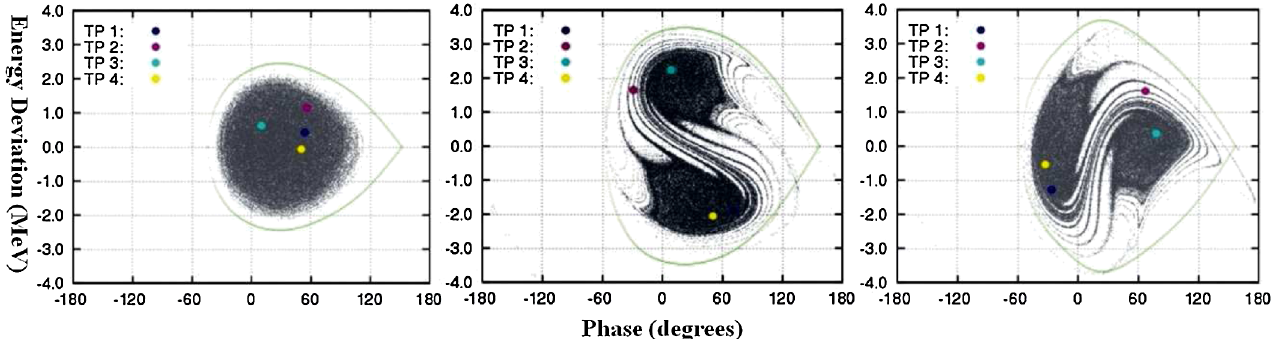
FIG. 4. (Color) Simulation results of dynamics in longitudinal phase space. The left graph is when rf PM is off. The center and right graphs, rf PM is on, two typical particle distributions are shown for different moments in the synchrotron motion. TP indicates test